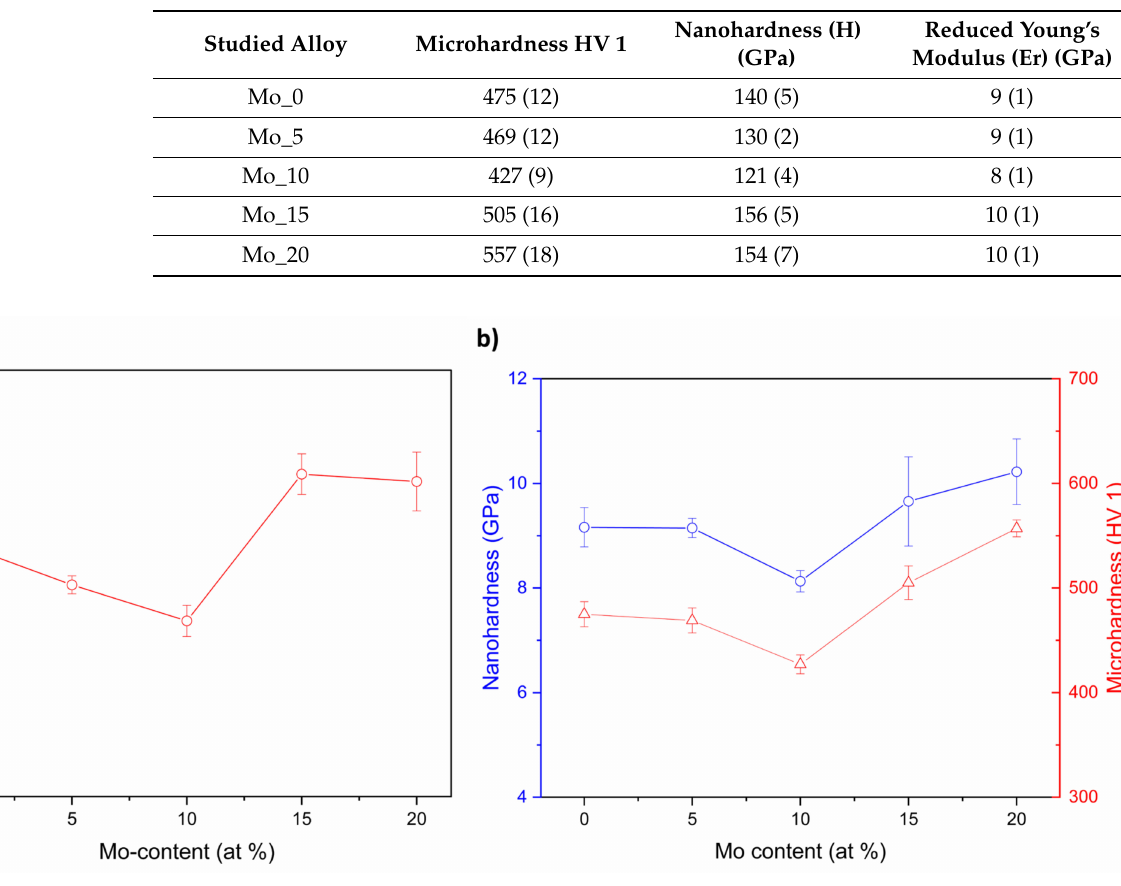
Figure 7. Reduced Young’s modulus ( a ), nanohardness and microhardness ( b ) values for different Mo content for studied high entropy